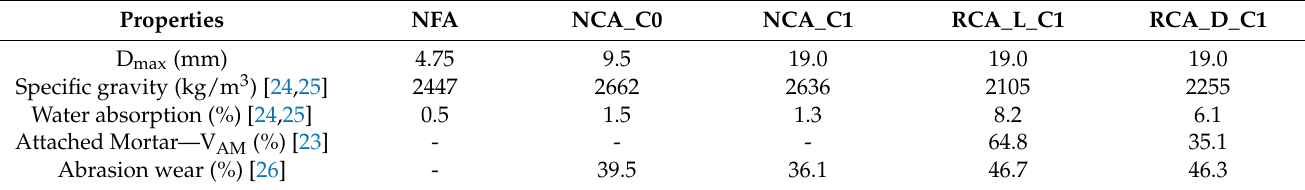
Table 1. Properties of the natural and recycled aggregates used (Rangel et al.